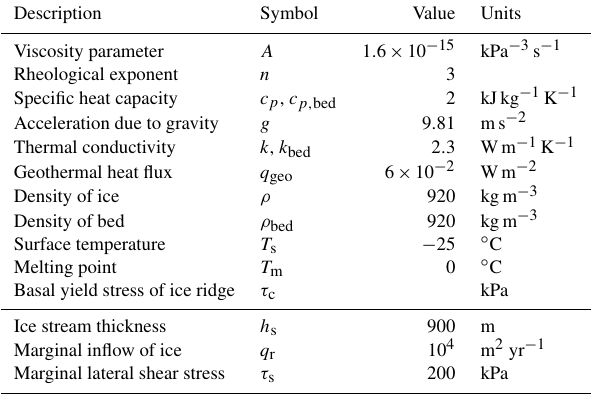
Table 1. Parameter values used in the sample calculations presented here. Ice stream thickness h s , lateral inflow of ice from the ridge q r , and marginal lateral shear stress τ s are highlighted as they repre- sent coupling with ice ridge and ice stream dynamics. h s and τ s correspond to the values observed at the upper margin of Whillans ice stream (Harrison et al., 1998), which migrates at a rate of 7 to 30myr − 1 (Hamilton et al., 1998; Harrison et al., 1998; Echelmeyer and Harrison, 1999). The q r estimate is based on an inflow velocity of 10myr − 1